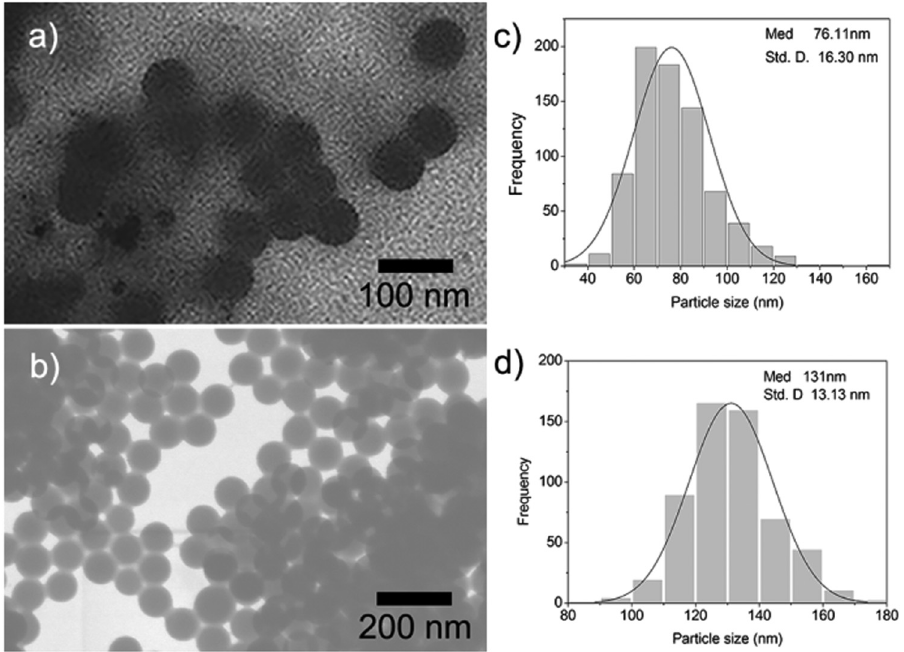
Figure 5: TEM micrograph of ( a ) empty copolymer micelles and ( b ) methotrexate - loaded micelles ( MTX/mPEG - PCL ) . The particle size distribution of ( c ) empty micelles and ( d ) MTX/mPEG -